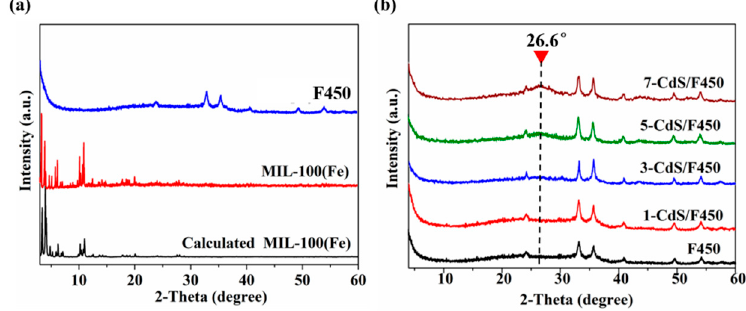
Scheme 1. Schematic flowchart for preparing of uniform samples of X–CdS / F450.